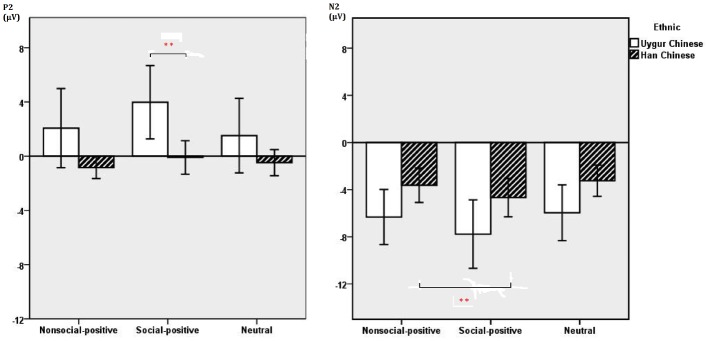
Average P2 (Left), N2 (Right) amplitudes of non-social positive, social positive, and neutral stimuli at Fz and Cz recording sites between Han Chinese (n = 21) and Uygur Chinese (n = 21). Error bars represent ±2 standard errors. **p < 0.05.